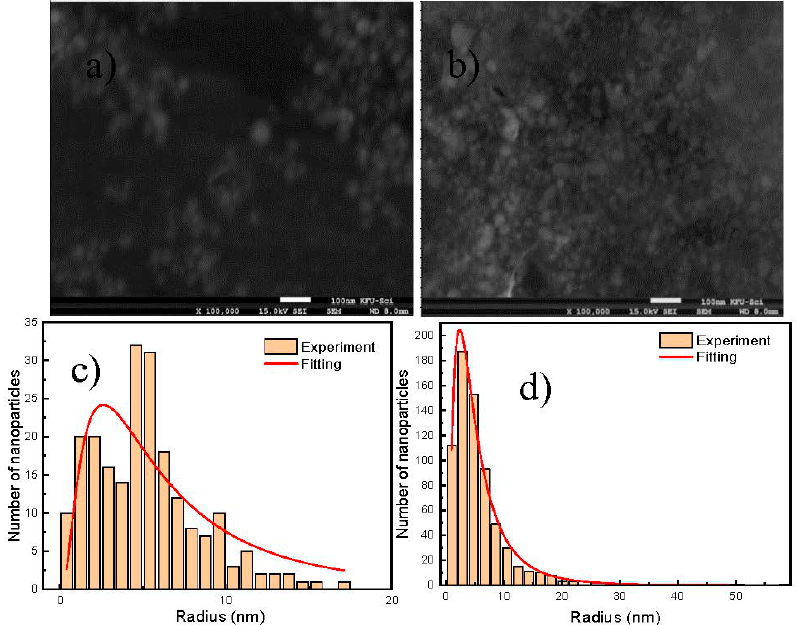
Figure 3. SEM images of Cit-AgNPs before mixing with EDTA + Cr (III) at different pH and size distribution of AgNPs taken from SEM image, the size distribution was fitted by a lognormal function − [ lnx / r ] 2 y = y 0 + A 1 √ e 2 σ 12 . ( a ) SEM image for pH = 3.6. ( b ) SEM image for pH = 9.6. ( c ) The average of size extracted for pH = 3.6 with its deviation is 12 nm (0.9 nm), adj. R-squared 0.852. ( d ) The average of size extracted for pH = 9.6 with its deviation is 8 nm (0.7 nm), adj. R-squared 0.998.